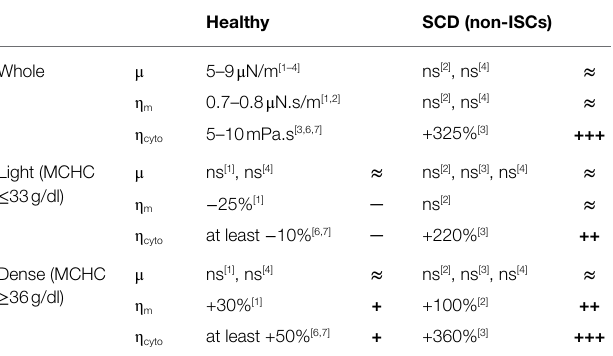
TABLE 1 | Mechanical properties of healthy and SCD RBCs reported in the literature, measured on either unsorted (whole) or density-sorted (light and dense) RBCs with different techniques (micropipette, membrane fluctuations, and